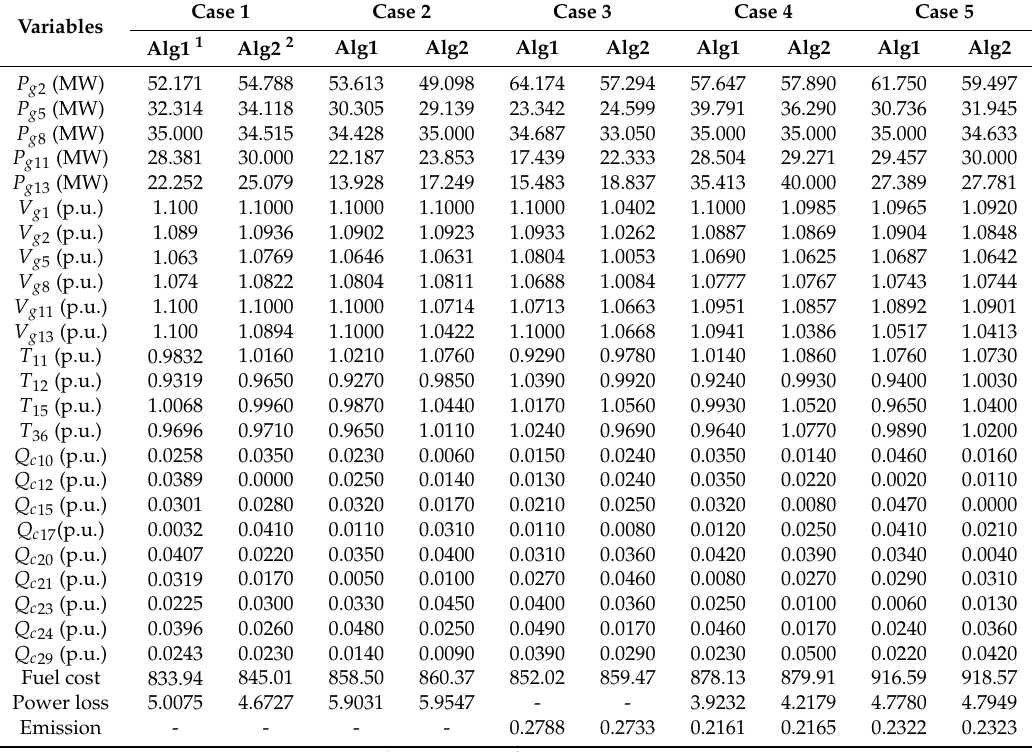
Table 5. Comparisons of the BCSs found by the MOFA-CPA and MOFA-PFA algorithms for Cases 1–5.